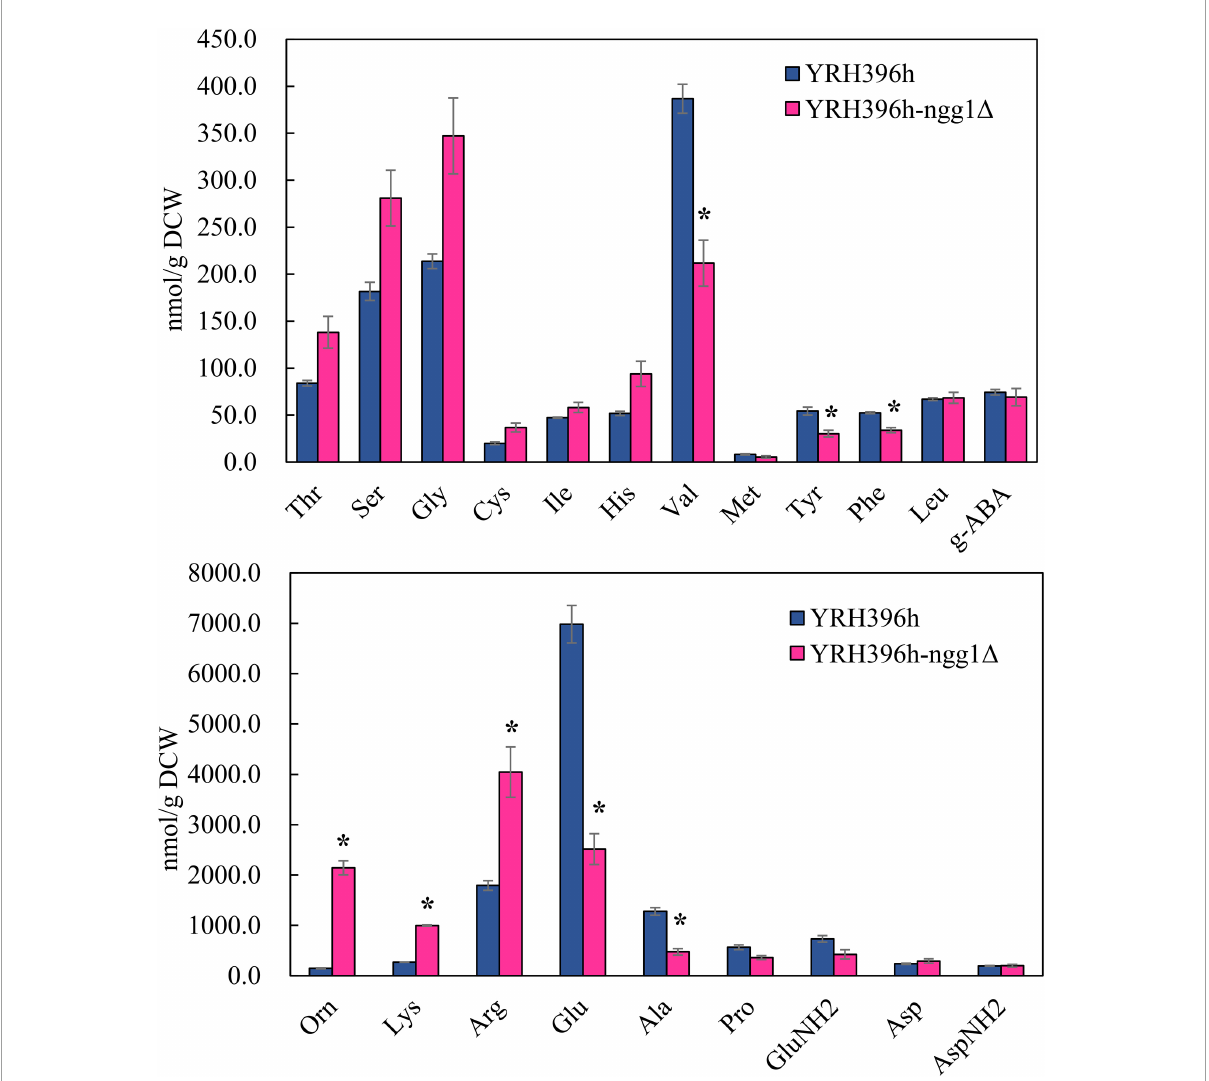
FIGURE5 Impact of NGG1 deletion on the content of intracellular amino acids of YRH396h. The NGG1 deletion strain and its parent strain S. cerevisiae YRH396h were grown in YP liquid medium using xylose as the sole carbon source, and cells were collected at log phase for the analysis of intracellular amino acids. * P <